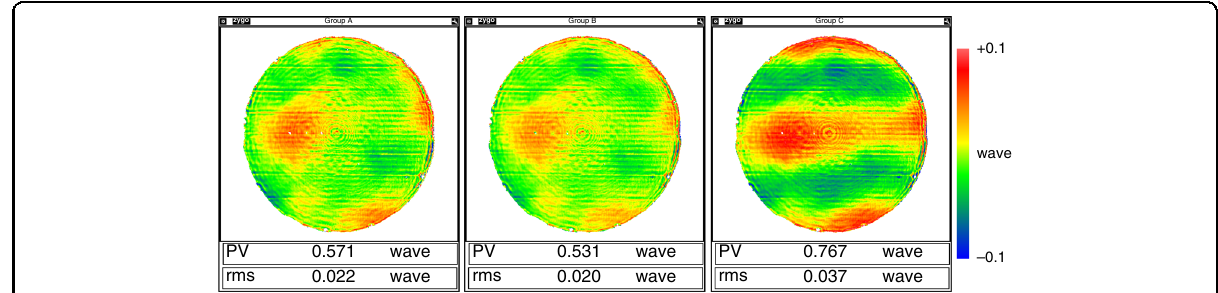
Fig. 21 Surface error map tested and comparison. a Group A, b Group B, c Group